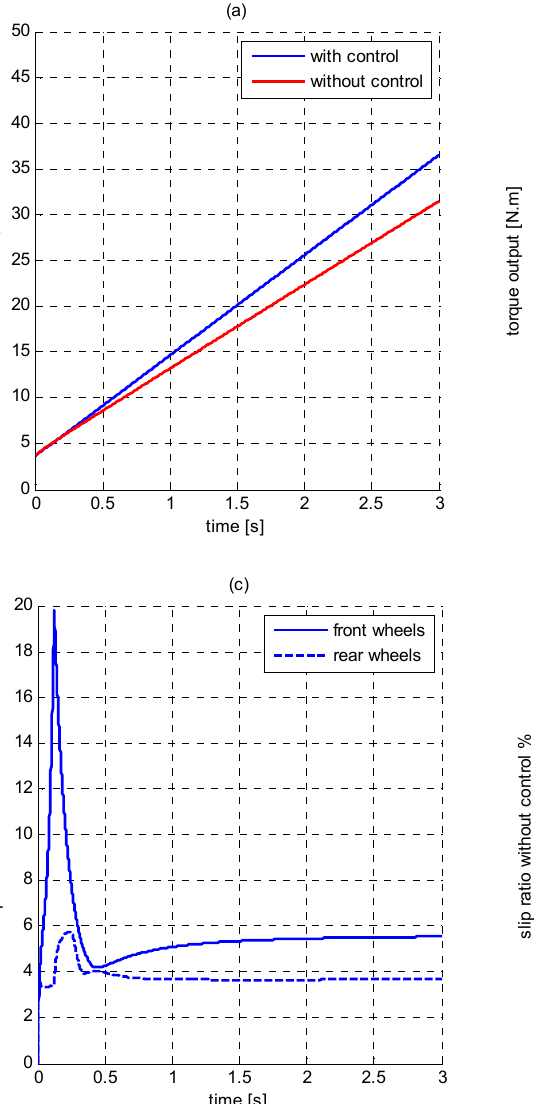
Table 4. Road surface input for front tires.